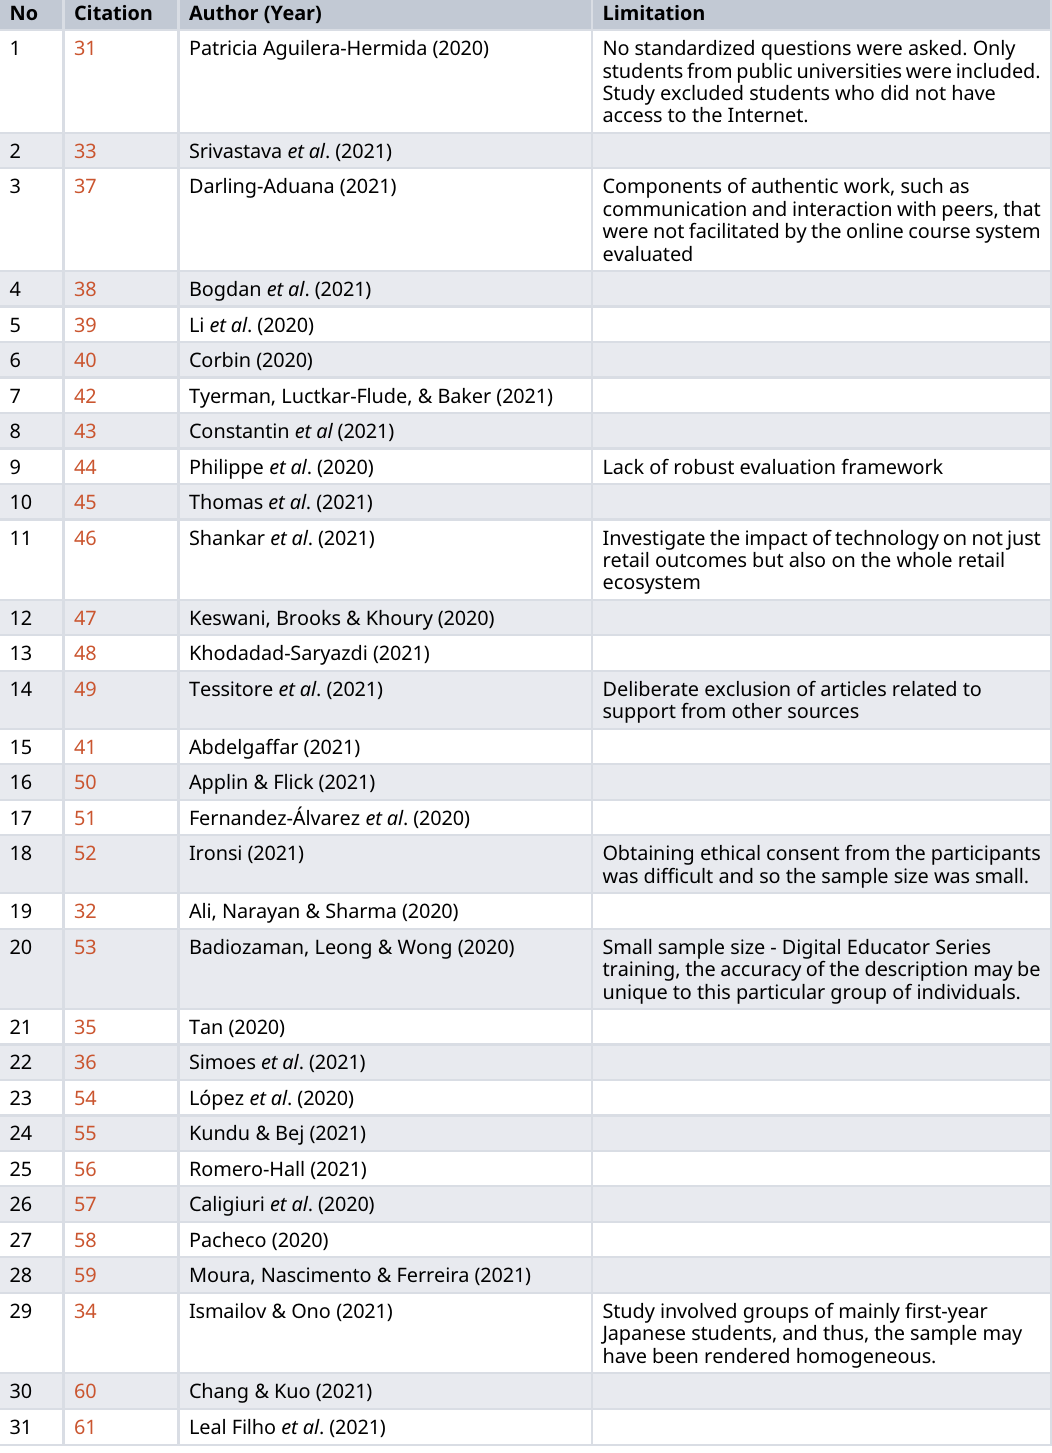
Table 8. Limitations of the